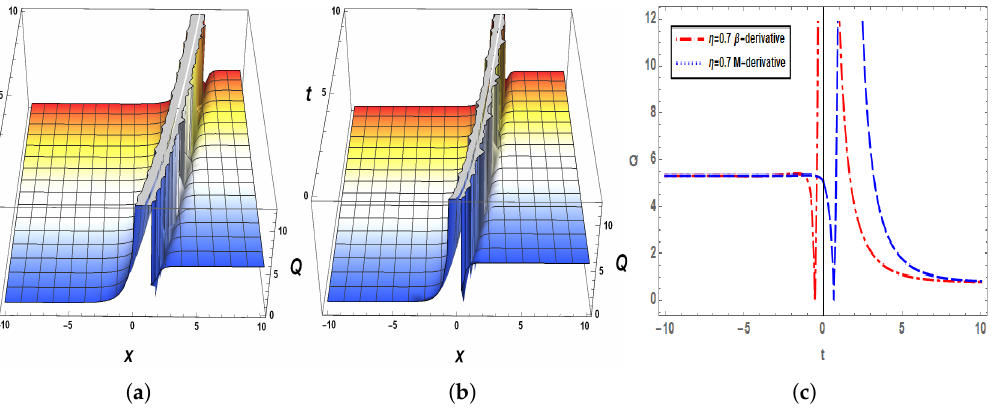
Figure 8. Graphical depiction of Q 8,2 ( x , t ) taking µ = 0.5, γ = − 0.8, σ = 0, θ = 1, ϑ = 1, (cid:101) = 0.5, λ = 1, and C = − 1. ( a – c ) reflect 3 D and 2 D profiles with Beta and M-truncated operators for η =